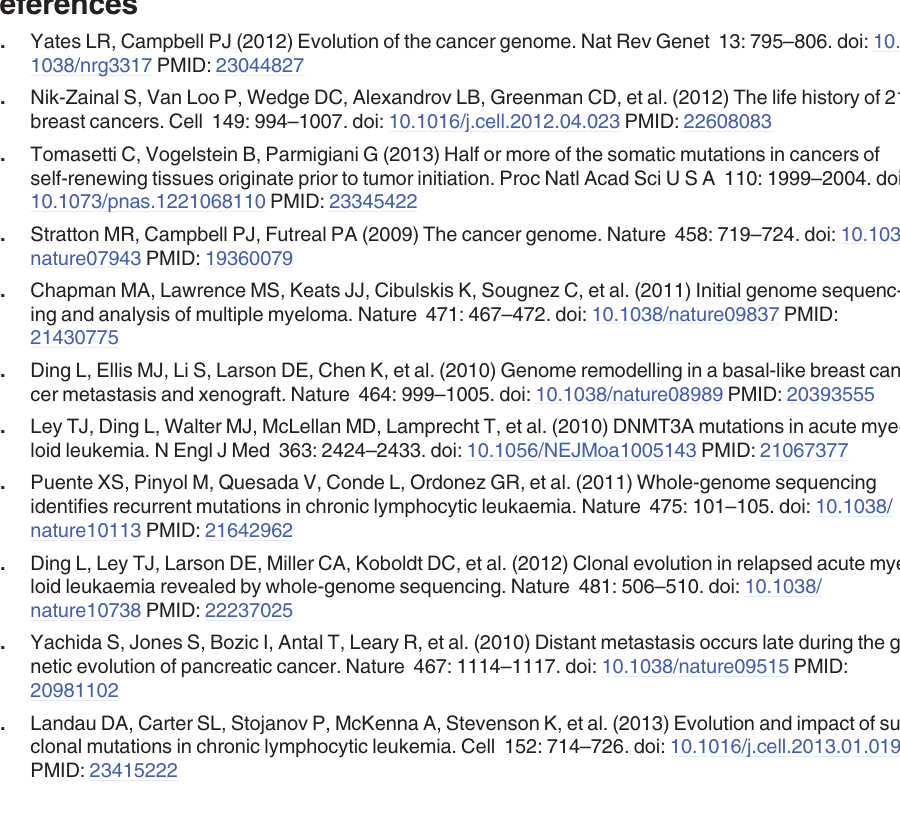
S3 Table. Timing of PAX fusion. Inferred occurrence timing of the PAX fusion event in PFN RMS samples is listed. S4 Table. Timing and expression of somatic mutations. Somatic mutations of which occur- rence time are inferable are listed. S5 Table. Significantly enriched gene sets by